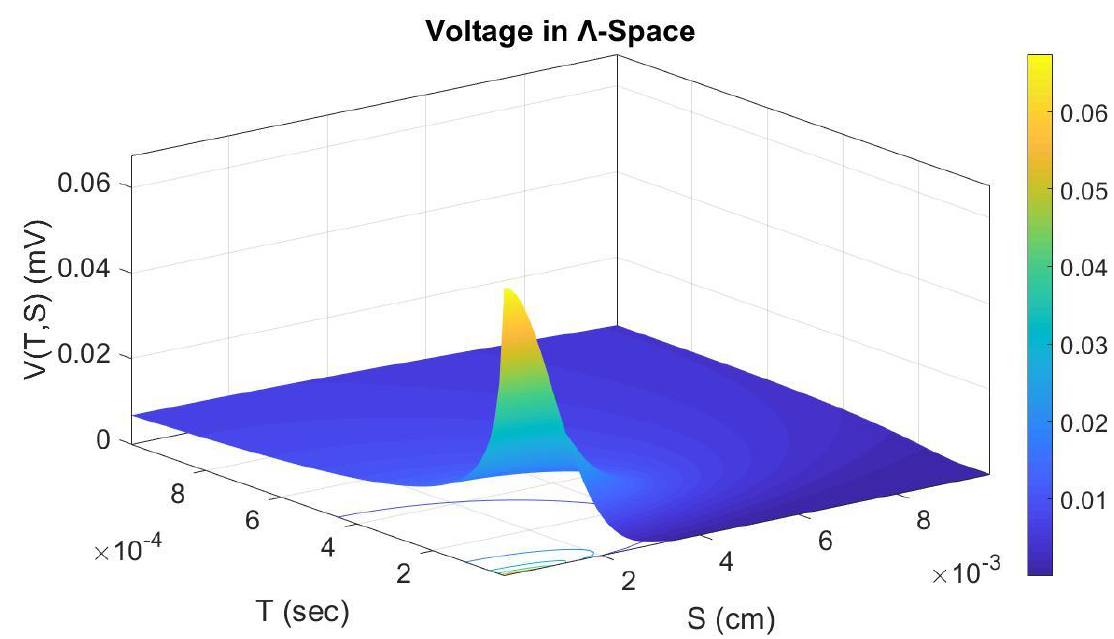
Figure 5. The voltage V Λ (T,S) in Λ -space as a function of time T and arc length S.